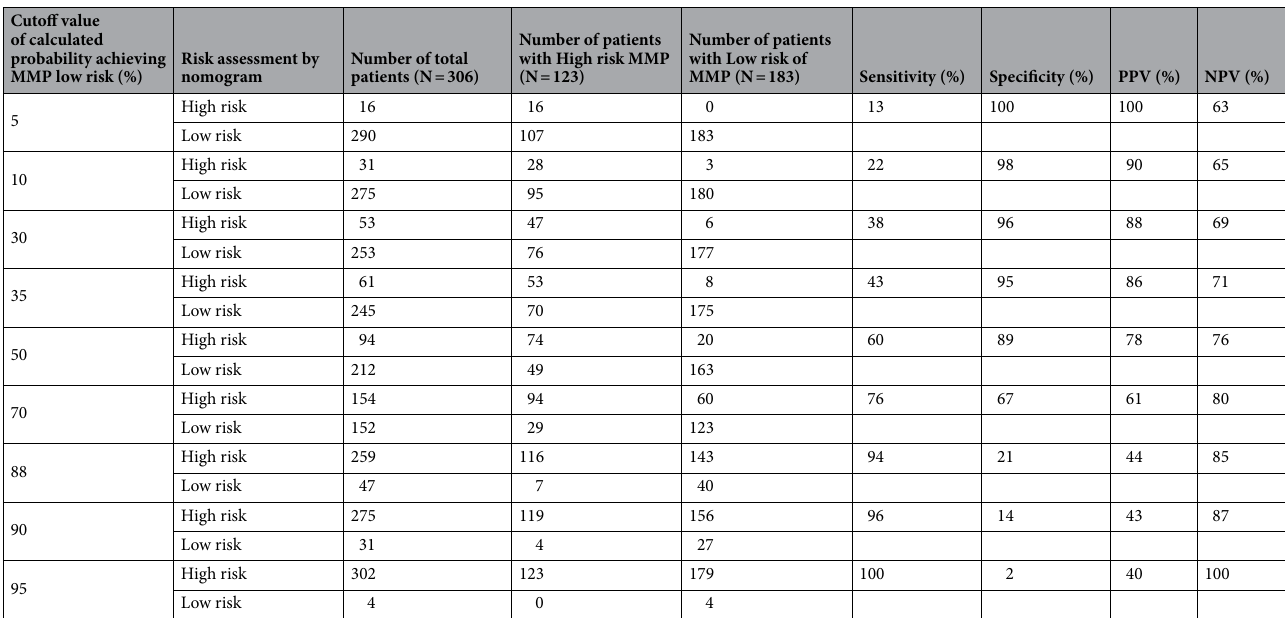
Table 4. Sensitivity, specificity, positive predictive, and negative predictive values according to various cutoff values. MMP, Mammprint test; PPV, positive predictive value; NPV, negative predictive